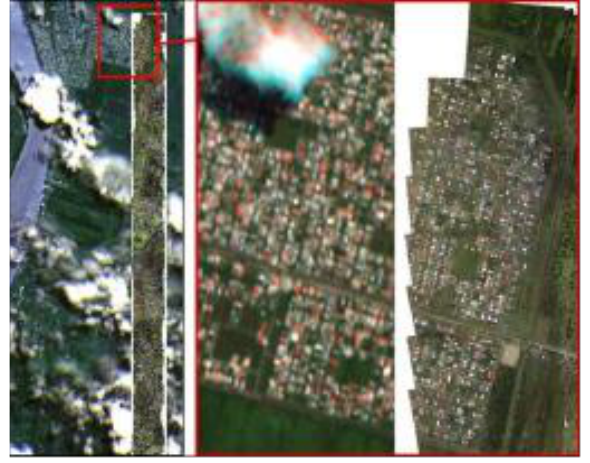
Figure 2: Comparative resolution of RapidEye and aerial imagery